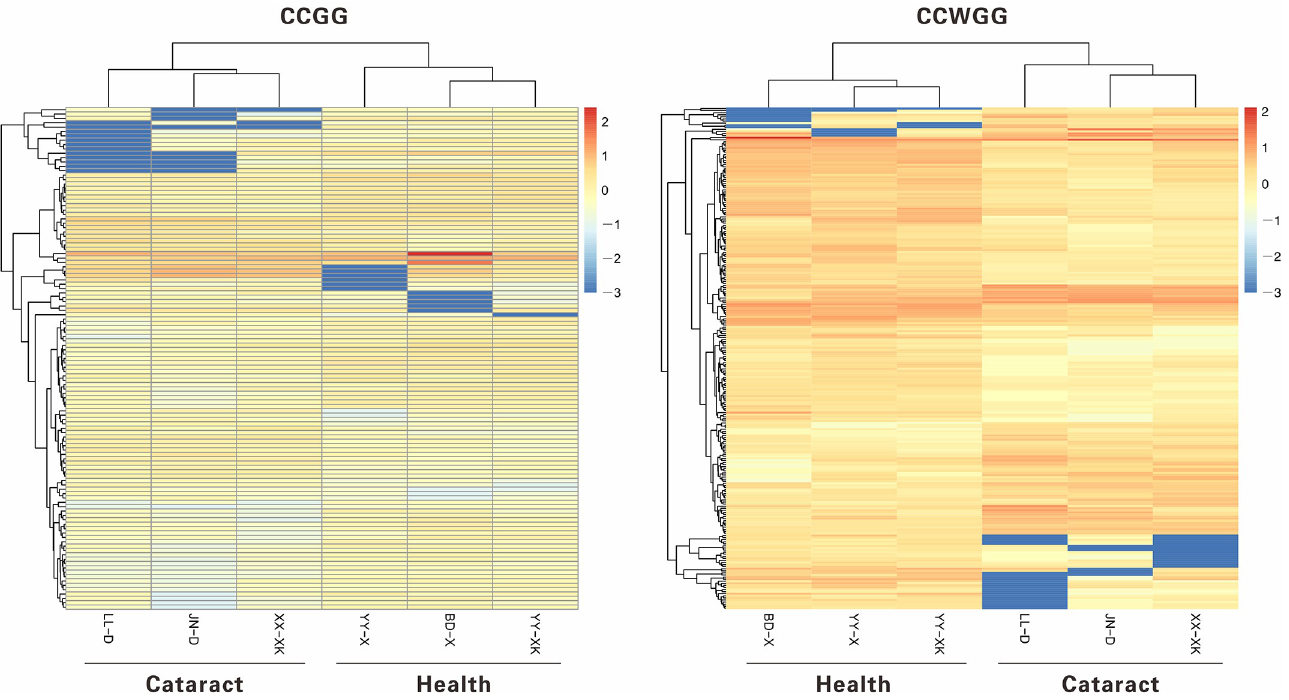
Fig 3. Cluster heat map of differentially methylated genes between group.